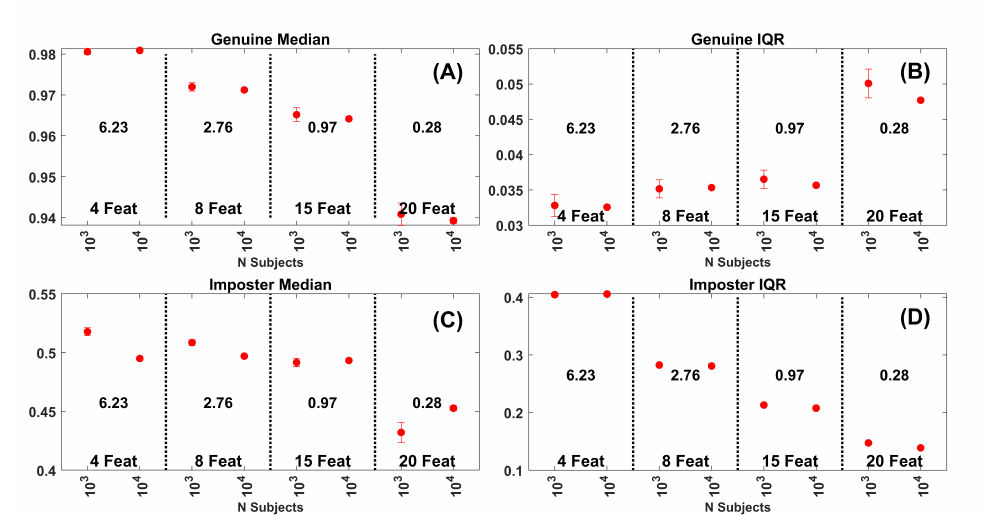
Figure 12. ( A ) Median of the genuine similarity score distributions for the FaceNet PCA Components. Results for 4, 8, 15 and 20 PCA components. Each dot is based on 30 repetitions. The error bars are at ± 1 SD . The numbers in the middle of each plot are the average EERs across the gallery sizes represented. ( B ) IQR of the genuine similarity score distributions for the same data in ( A ). ( C ) Median of the impostor similarity score distributions. ( D ) IQR of the impostor similarity score